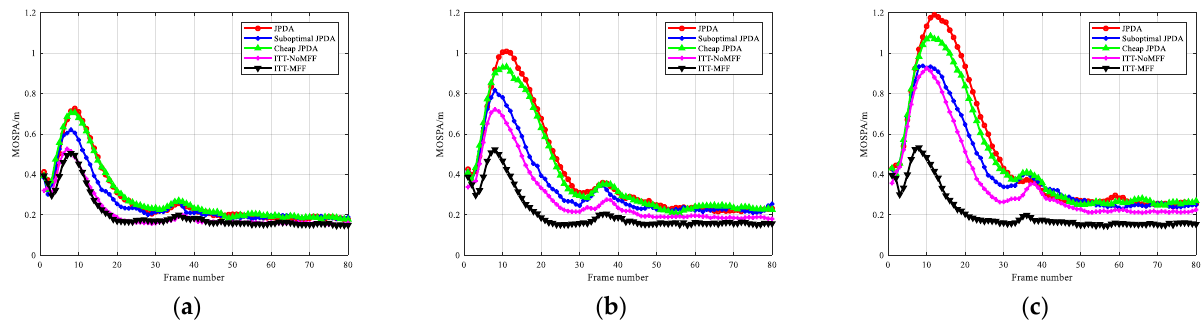
Figure 7. MOSPA comparisons of the two target scenarios with different clutter densities: ( a ) λ = 10 − 5 ; ( b ) λ = 10 − 4 ; ( c ) λ = 10 − 3 .